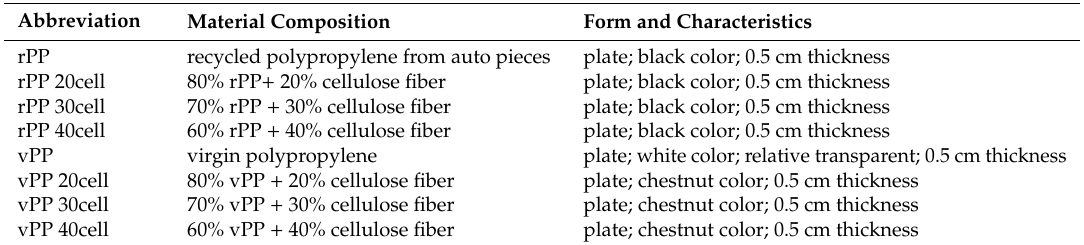
Table 1. Characteristics of materials